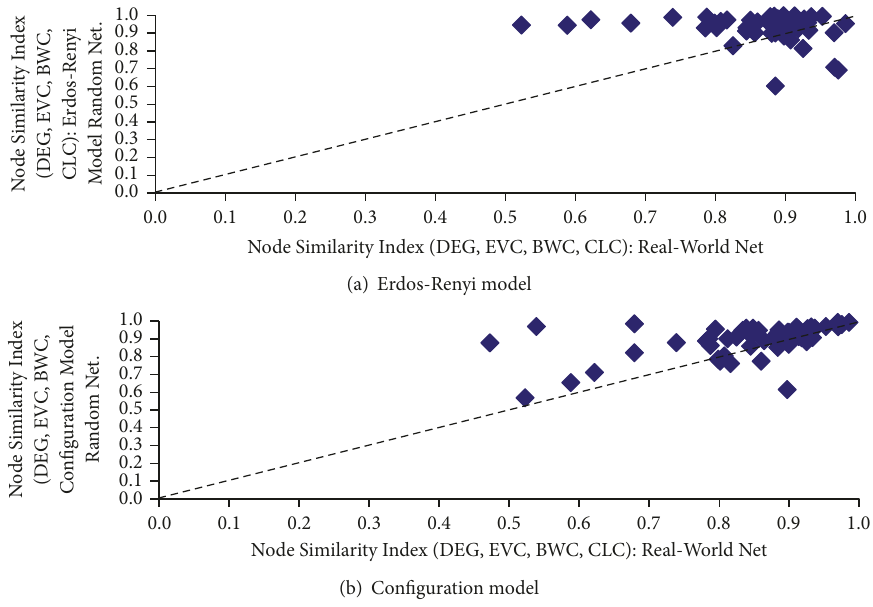
Figure 7: Comparison of the (DEG, EVC, BWC, CLC)-based NSI values for the real-world networks and the random networks generated using the Erdos-Renyi model and the Configuration